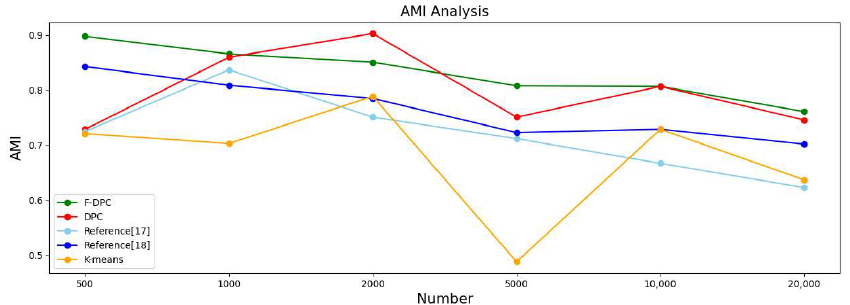
Figure 17. Line chart of evaluation index AMI.